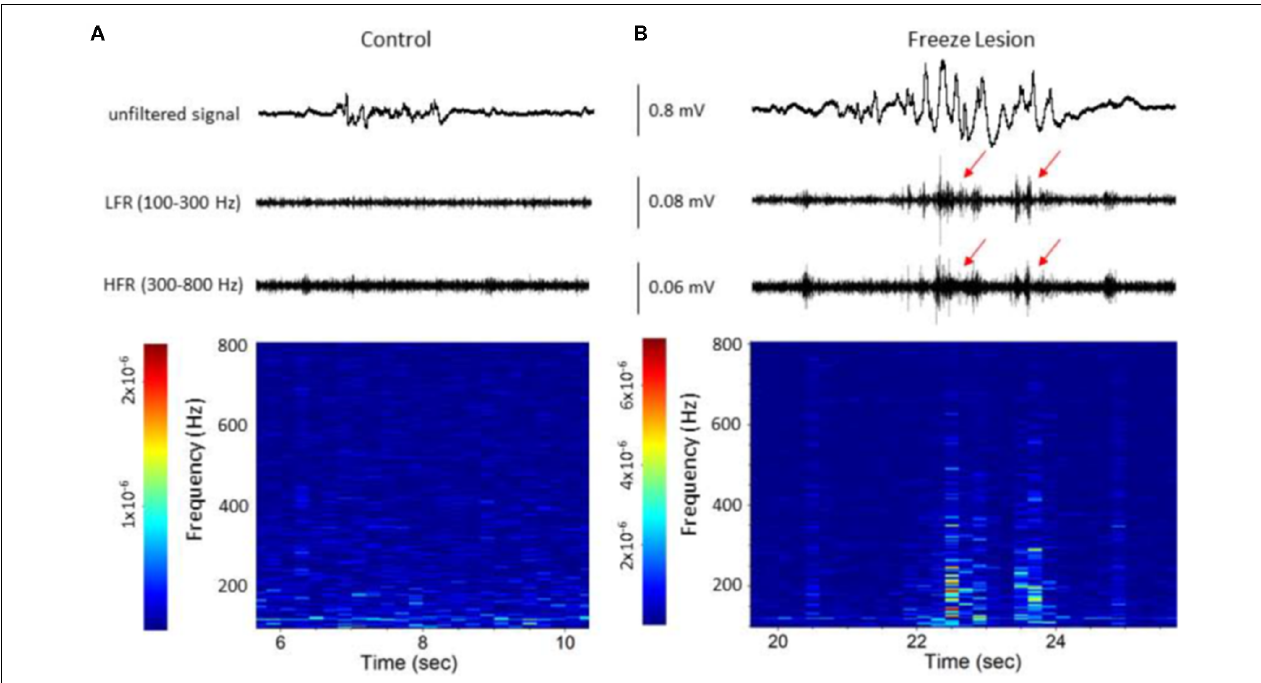
FIGURE 5 | Spectrograph analysis of B-S events demonstrating the increase in high-frequency spectral power that was observed during the HFOs. (A) B-S event from a control animal indicating a lack of HFOs (i.e., LFR and HFR, upper panel) and minimal change in high-frequency spectral power (spectrograph, lower panel). (B) B-S event from a freeze lesion animal indicating the presence of HFOs (red arrows, upper panel) and subsequent increase in high-frequency spectral power (spectrograph, lower panel). (A,B) The corresponding signal is presented above each spectrograph. Recordings are representative samples from the most superficial linear array electrode (CH01) of both a control and freeze lesion animal. Scale bar represents the PSD (dB) level for each spectrotemporal